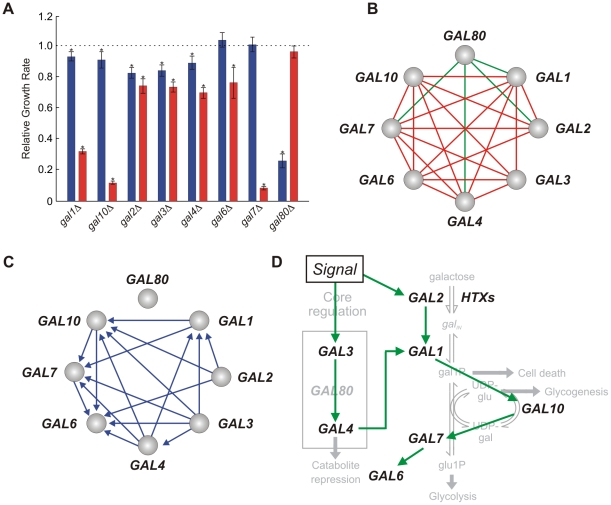
Analysis of fitness traits.(A) Relative fitness for single GAL gene deletions, in presence (red) and absence (blue) of galactose. Asterisk marks significant effect (t-test p-value <0.05). (B) Signal-dependent genetic interactions (green: δI>0, red: δI<0, t-test p-value <0.05). (C) Inferred causal relationships. (D) Transitive reduction of the network in (C).